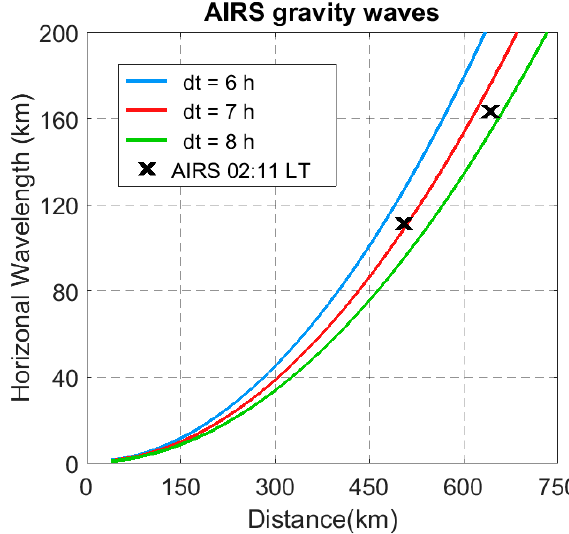
Figure 5. Temporal and spatial horizontal wavelengths variations measured by AIRS at 02:11 LT on 11th August.